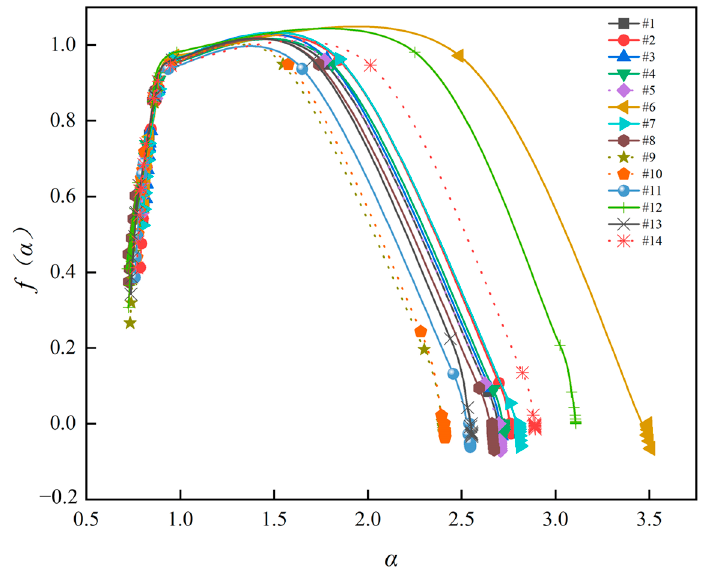
Figure 9. Relationship between f ( a ) and a (samples of solid lines used to establish the model, samples of dotted line used to verify the